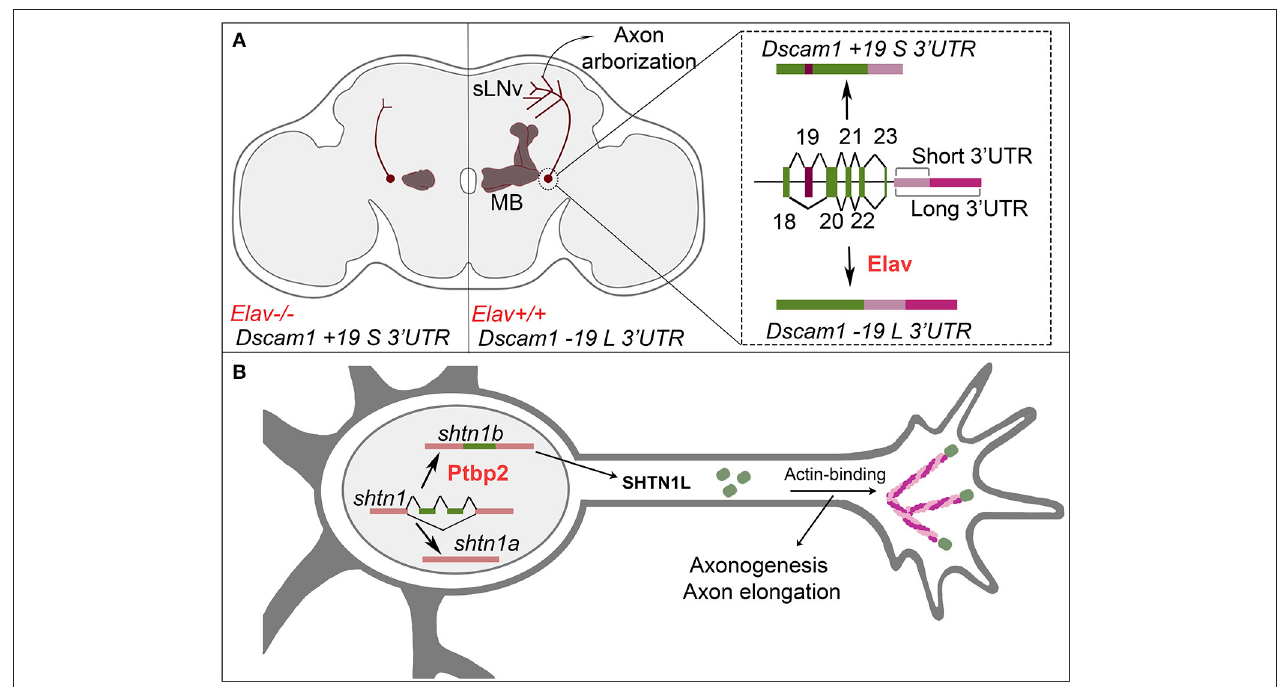
FIGURE 2 | Alternative cleavage/polyadenylation and AS control neuronal wiring. (A) Regulation of alternative cleavage/polyadenylation and exon skipping control axon branching and axon arborization. (Right) The RBP Elav mediates the skiping of exon 19 and the selection of the long 3 ′ UTR isoform for Dscam1 . (Center) The Dscam1 -19 L 3 ′ UTR is required for bifurcation of Drosophila mushroom body (MB) axons, and correct formation of axon arborizations in sLNv neurons. (Left) Loss of Elav or loss of the long 3 ′ UTR of Dscam1 leads to bifurcation and growth defects in mushroom body axons, and loss of axonal arborizations in sLNv neurons. (B) Regulation of AS of shtn1 coordinates axonogenesis and axon elongation. AS of shtn1 leads to two different isoforms via the inclusion/exclusion of two exons. The RBP Ptbp2 mediates the inclusion of two exons to produce the shtn1b/shtn1L isoform. The SHTN1L isoform binds actin to allow the formation of actin filaments, which leads to axonogenesis and axon elongation. In absence of Ptbp2 or shtn1L , axonogenesis is